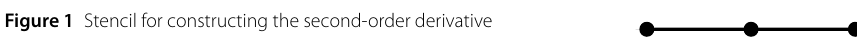
Figure 1 Stencil for constructing the second-order